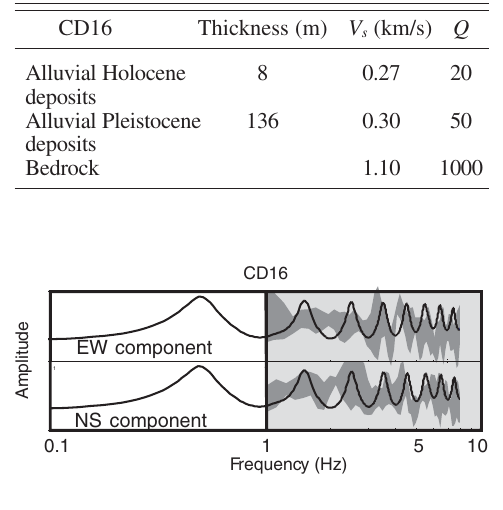
Fig. 8 . Theoretical 1D transfer function at CD16 (Haskell-Thompson method) for the stratigraphy of table IV, compared to earthquakes spectral